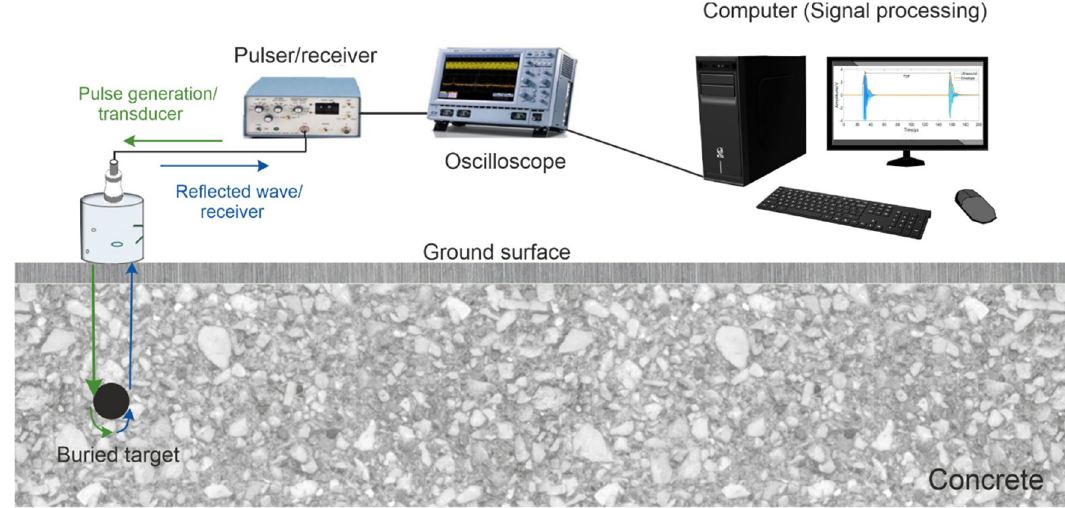
Figure 14. Pulse-echo ultrasound technique scheme [196].